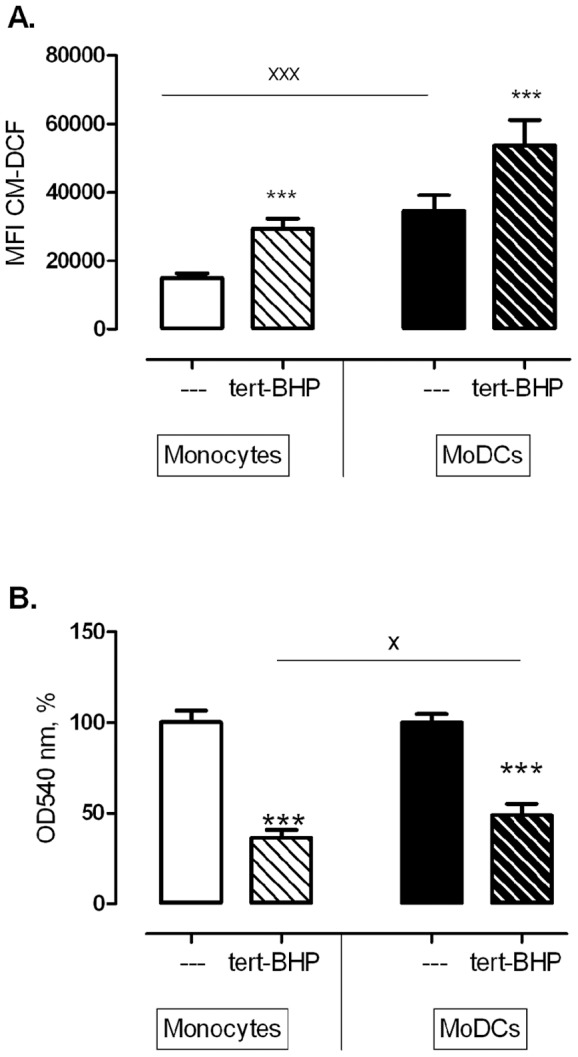
Tert-BHP induced ROS production and cell death in monocytes and moDCs.
A.
CM-H2DCF fluorescence measured by FCM, before and after addition of tert-BHP (200
µM). Repeated measures ANOVA (with differentiation and stimulus as within-subject factors), revealed a significant increase after tert-BHP and significantly more fluorescence in moDCs than in monocytes, but both cell types responded similar to tert-BHP, as indicated by the lack of interaction (n = 8). B.
Cell death induced in monocytes and moDCs by tert-BHP (200
µM, 30
min). Tert-BHP induced cell death in both cell types, but moDCs appeared to be more resistant to tert-BHP induced cell death. ***P<0.001 tert-BHP versus untreated control (One sample t-test, n = 16), xP<0.05, xxxP<0.001 monocytes versus moDCs (Repeated measures ANOVA, n = 16).